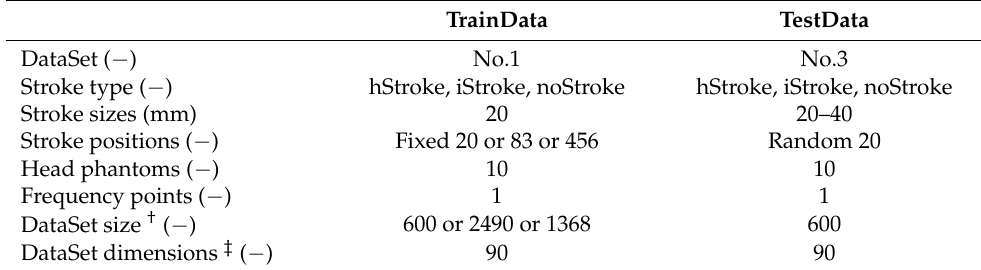
Table 6. Training and testing data parameters for hypothesis H4.